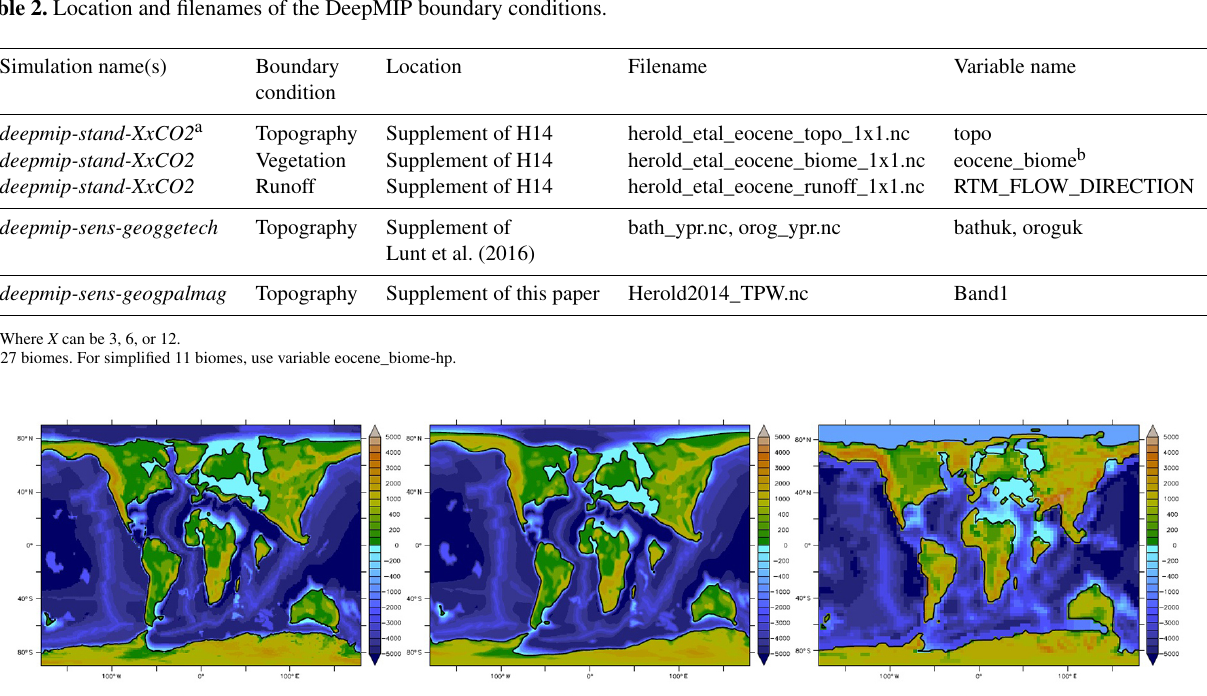
Table 2. Location and filenames of the DeepMIP boundary conditions.